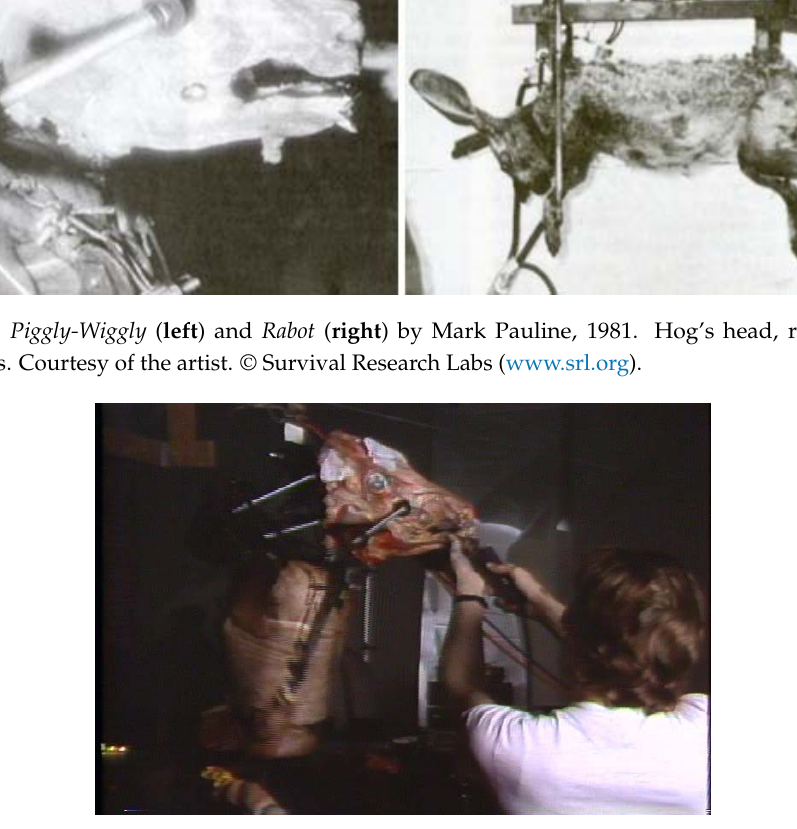
Figure 6. Animated sculpture for Night of the Succubus by Mark Pauline and Monte Cazzaza, 6 June 1981, Ed Mock Dance Studio, San Francisco. Pig, robotic structure. © Survival Research Labs.